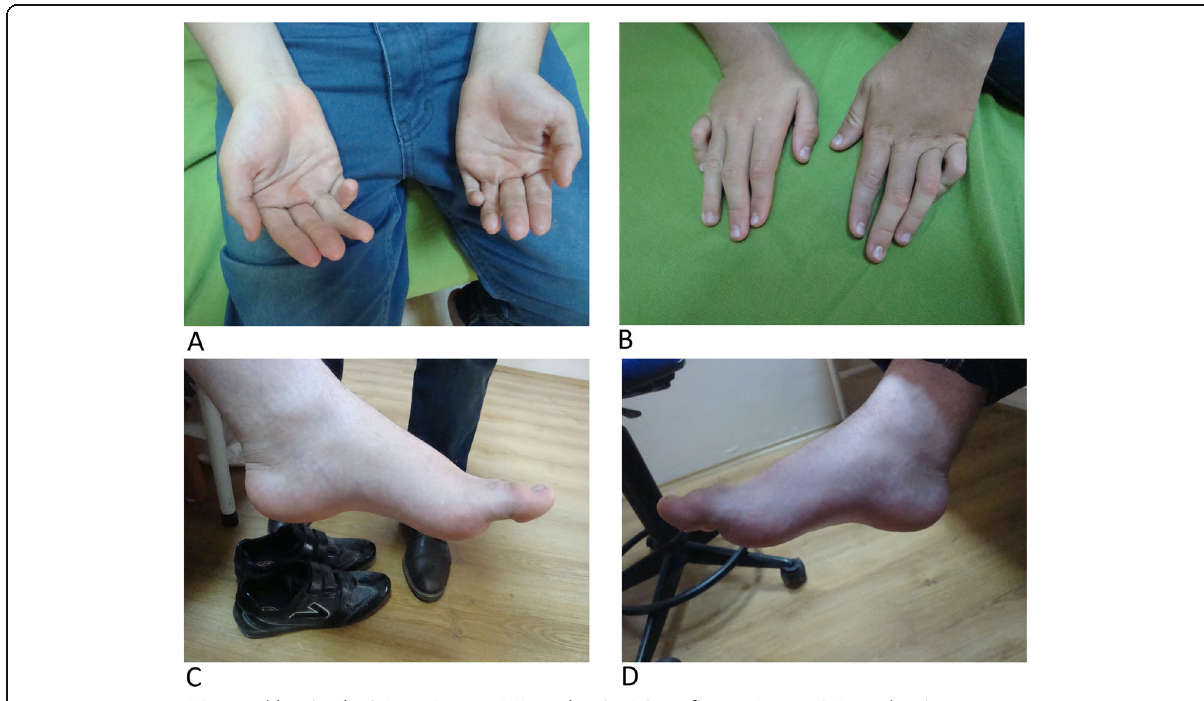
Fig. 1 Clinical findings of the